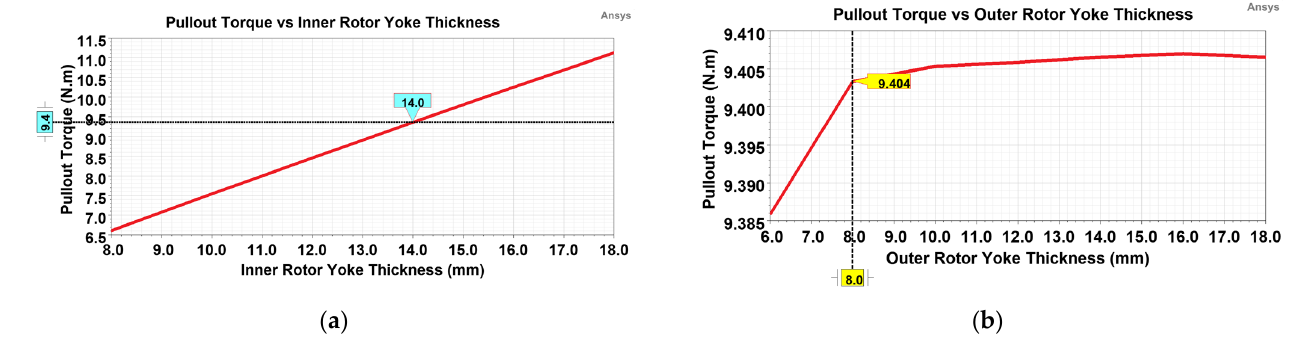
Figure 11. Pullout torque versus: ( a ) Thickness of inner yoke; ( b ) Thickness of outer yoke.